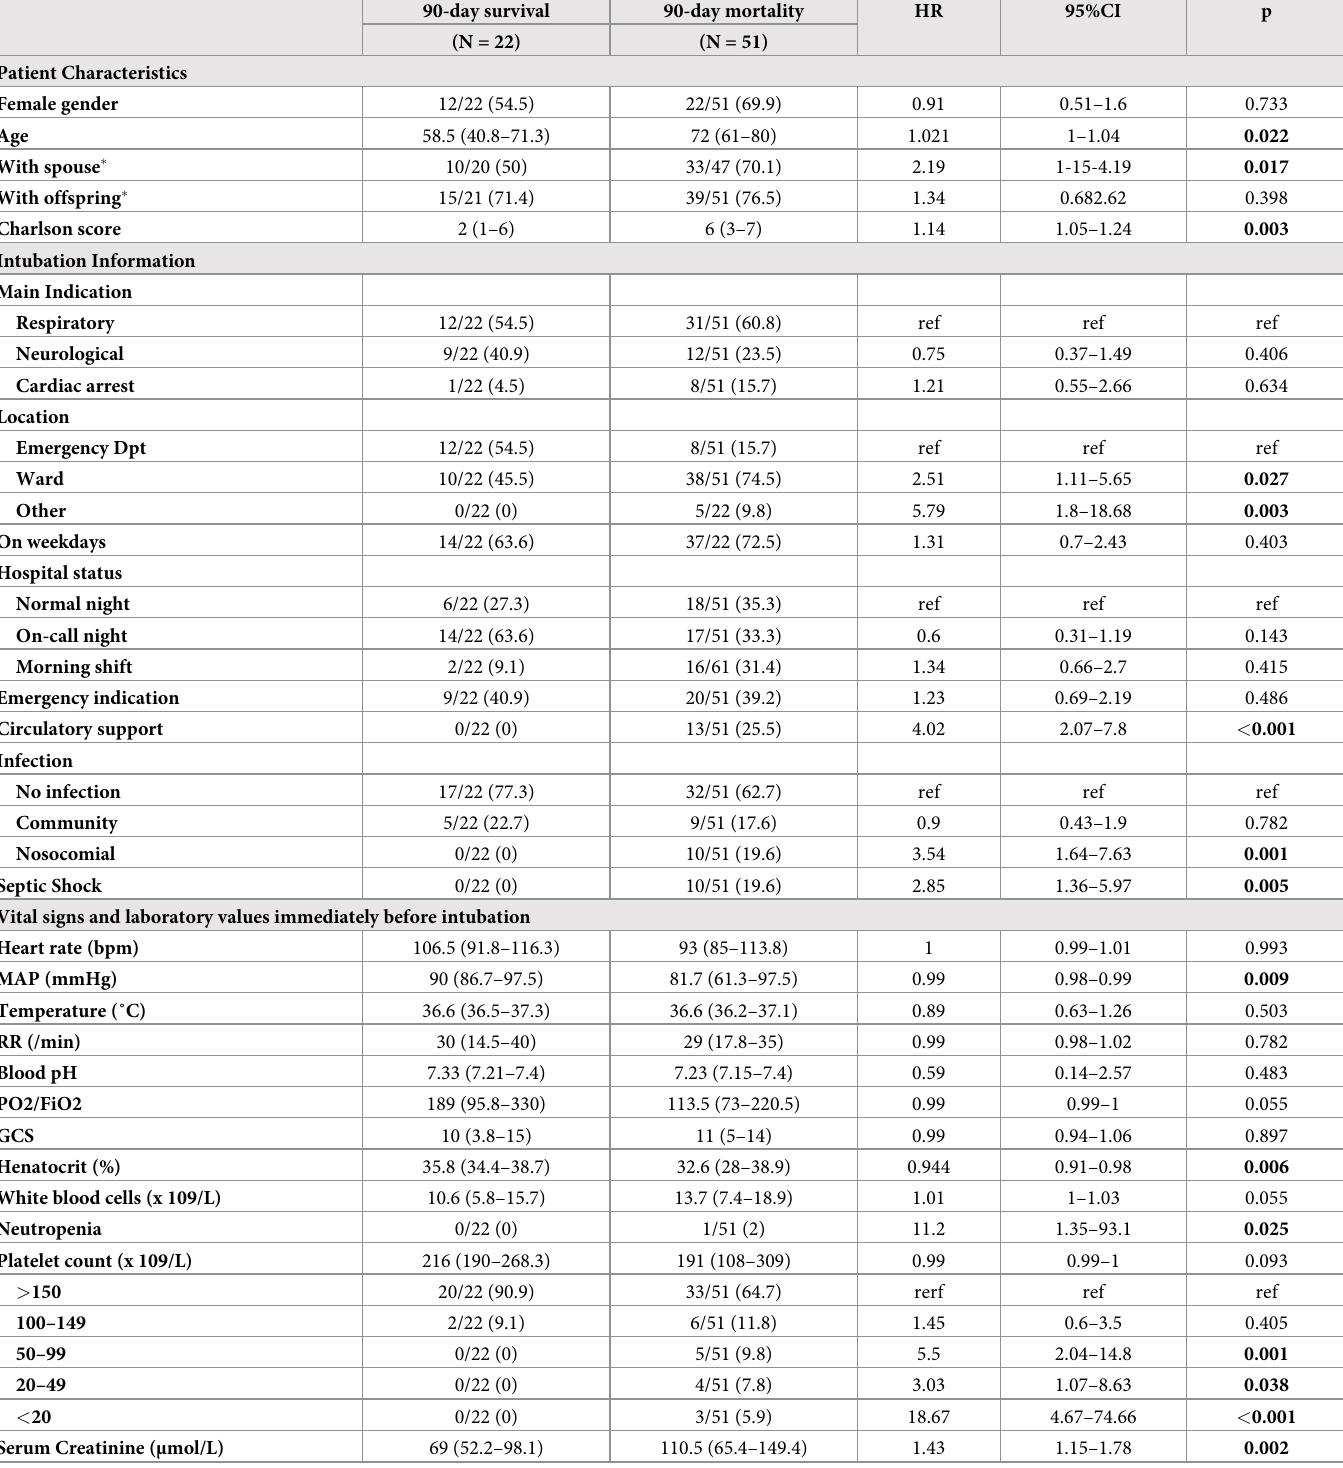
Table 5. Demographic, clinical, and laboratory characteristics at the time of their intubation of survivors vs. non-survivors over the 90-day follow-up amongst the population that was transferred to the ICU during the hospital